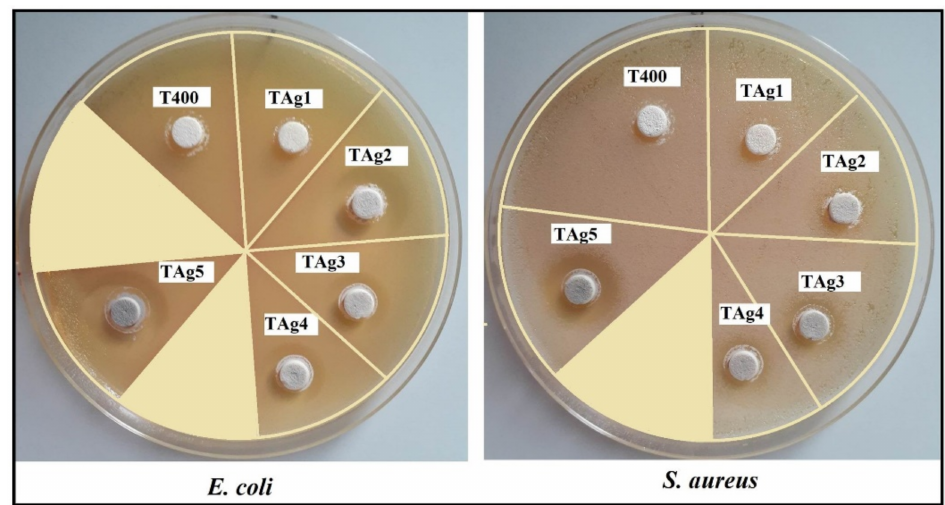
Figure 12. Image of a culture plate for evaluation of antimicrobial activity against S. aureus and E. coli . The MIC of the samples against E. coli was as low as 2.5 mg/mL for sample TAg5, and 5 mg/mL for the same sample against S. aureus (see Table 6). Table 6. Antimicrobial activities of the samples against S. aureus and E. coli . MIC: minimum inhibitory